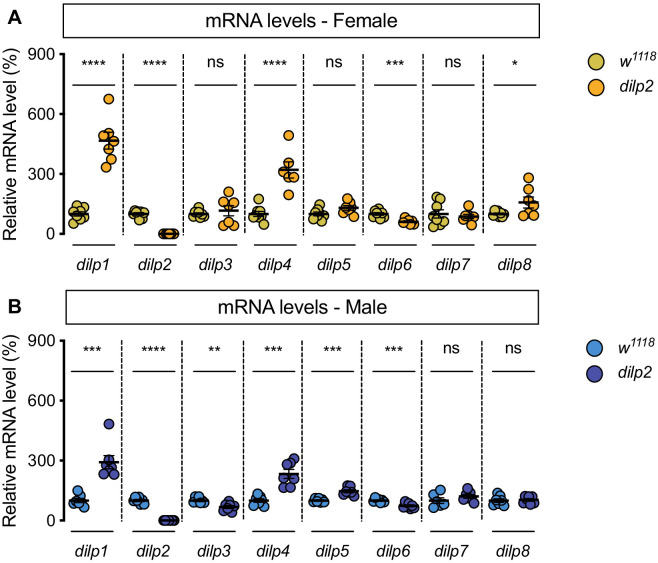
Genotype-dependent changes to dilp mRNA levels.(A) In dilp2 mutant females, mRNA levels of dilp1, dilp2, dilp4, dilp6, and dilp8 were significantly different from w1118 control females (p<0.0001,<0.0001,<0.0001, 0.0003 and 0.0454, respectively; Student’s t test), but mRNA levels of dilp3, dilp5, and dilp7 were not significantly different (p=0.5142, 0.0574, and 0.605, respectively; Student’s t test). n = 6–8 biological replicates. (B) In dilp2 mutant males, mRNA levels of dilp1, dilp2, dilp3, dilp4, dilp5, and dilp6 were significantly different from w1118 control males (p=0.0001,<0.0001, 0.0034, 0.0001, 0.0001, and 0.0008, respectively; Student’s t test), but mRNA levels of dilp7 and dilp8 were not significantly different (p=0.2302, and 0.7809, respectively; Student’s t test). n = 6–7 biological replicates. * indicates p<0.05, ** indicates p<0.01, *** indicates p<0.001, **** indicates p<0.0001; ns indicates not significant; error bars indicate SEM.